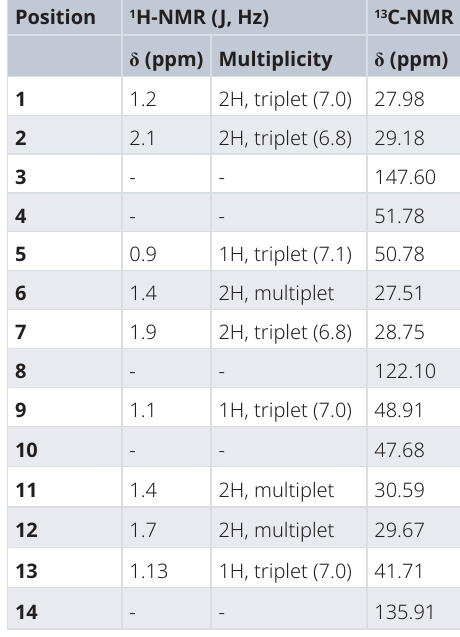
Table 1. 13C-NMR spectrum (500 MHz, CDCl3) of compound 1, Lamesticumin